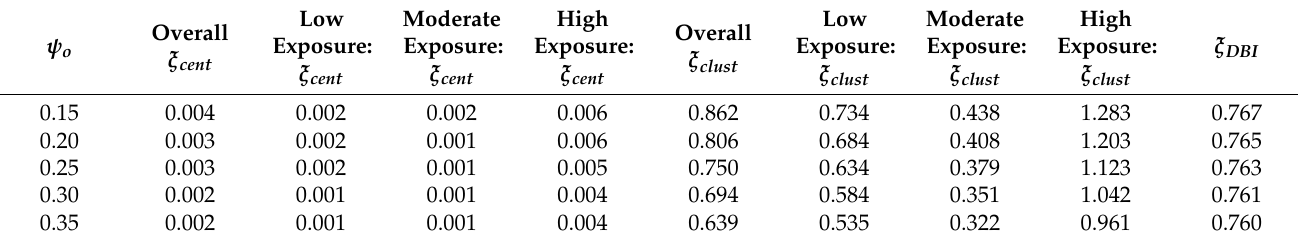
Table 20. Sensitivity analysis of the proposed method for the assignment of tourist